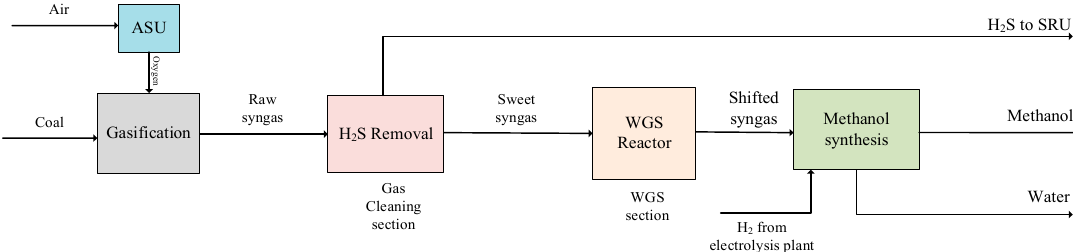
Figure 4. Block flow diagram for the modified design-2 (MD2-CTM) process.